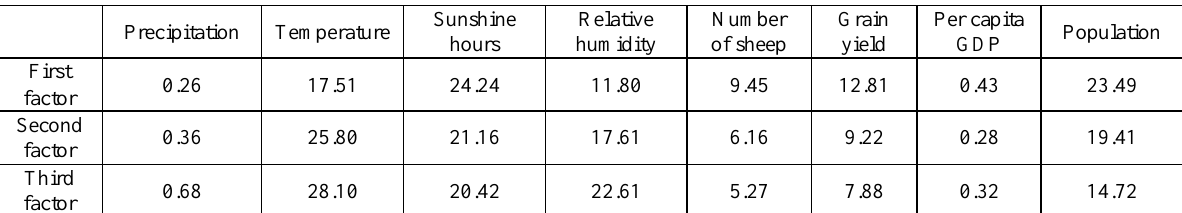
Table 1. Percentage of dominant factors affecting RUE changes